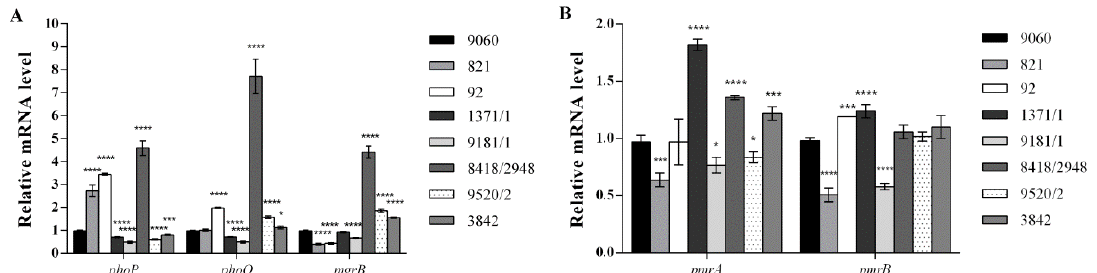
Figure 1. Relative expression level of colistin-resistance associated genes from tested colistin-resistant S. Infantis isolates. ( A ) Relative expression level of the phoP , phoQ , and mgrB genes. ( B ) Relative expression level of the pmrA and pmrB genes. All expression results were normalized relative to the gyrB gene by the 2 − ∆∆ Ct method. Values are the means from results obtained in triplicate. Error bars represent the standard deviation of the mean value. One way ANOVA followed by Tukey’s post hoc test was used to compare the results obtained for colistin-resistant isolates to those for colistin-susceptible isolate Salmonella Infantis 9060((* p < 0.05, *** p < 0.001, and **** p <